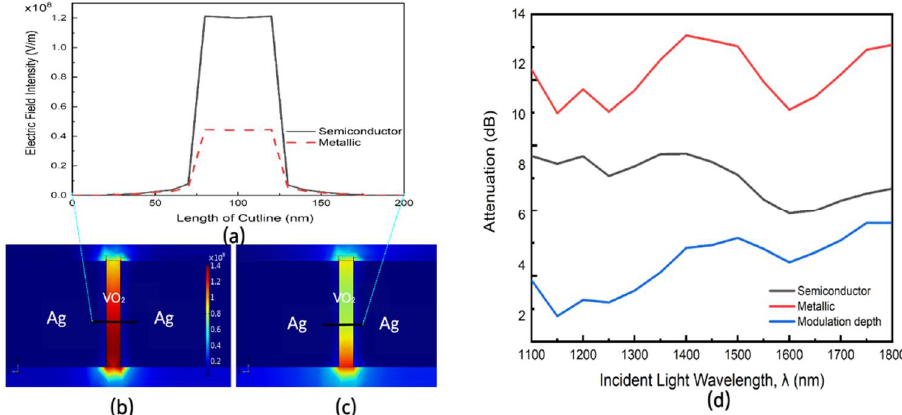
Figure 3. ( a ) Electric field Norm variation along cutline through plasmonic slot showing strong field confinement, Longitudinal cross section of the device in ( b ) OFF state (VO 2 in semiconductor phase) ( c ) ON state (VO 2 in metallic phase) ( d ) Insertion loss in both the metallic phase (ON phase) and the semiconductor phase (OFF phase) for incident light wavelength (λ) swept from 1100 nm to 1800 nm from simulation study.